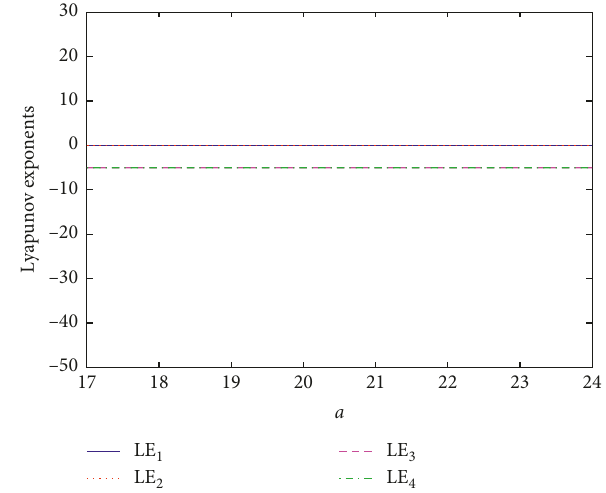
Figure 5: Lyapunov exponents of chaotic system (6) versus pa- rameter a .